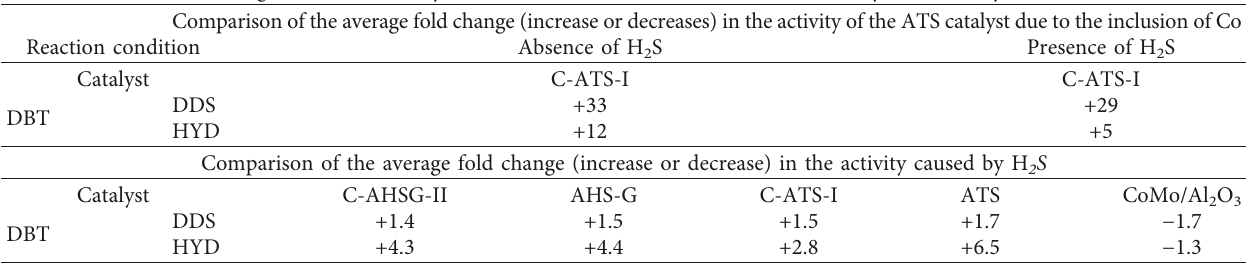
Figure 6: Effect of the Co content on the HDS activity (a) and the relationship between the activity and the selectivity (b).